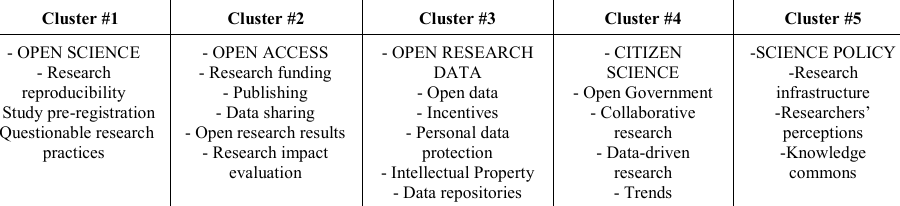
Table 2. The most compatible concepts in OS research (based on cluster